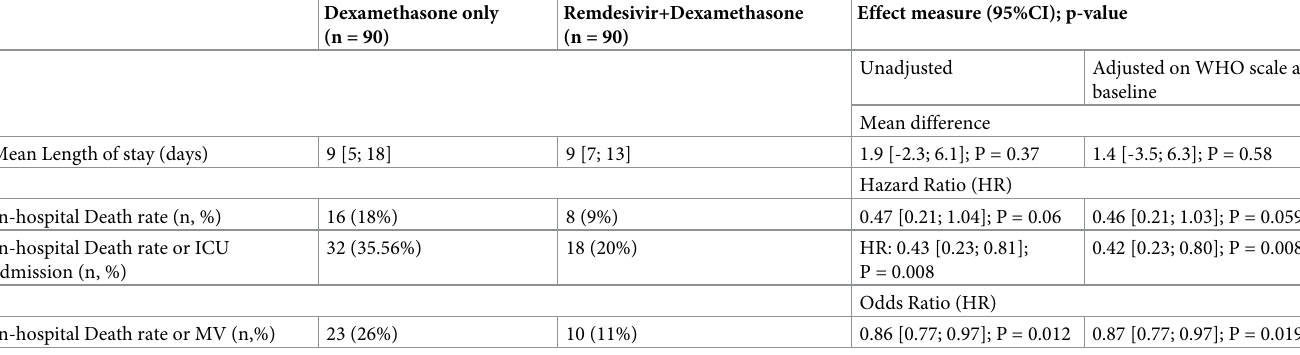
Table 2. Outcomes according to treatment group in the propensity score matched